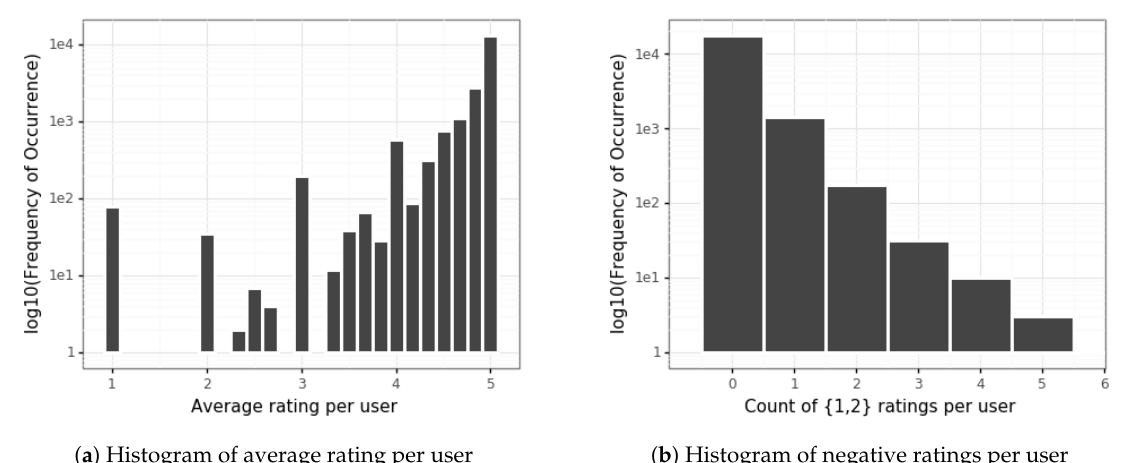
Figure 3. Histograms of average rating per user, and negative rating per user in logarithmic